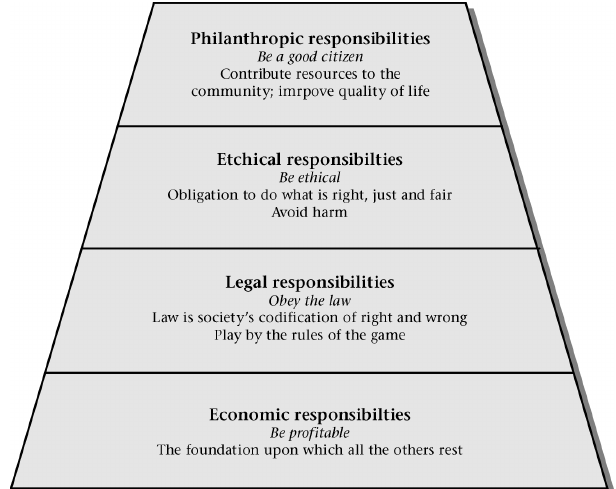
Figure 1: Carroll’s (1991) Pyramid of Corporate